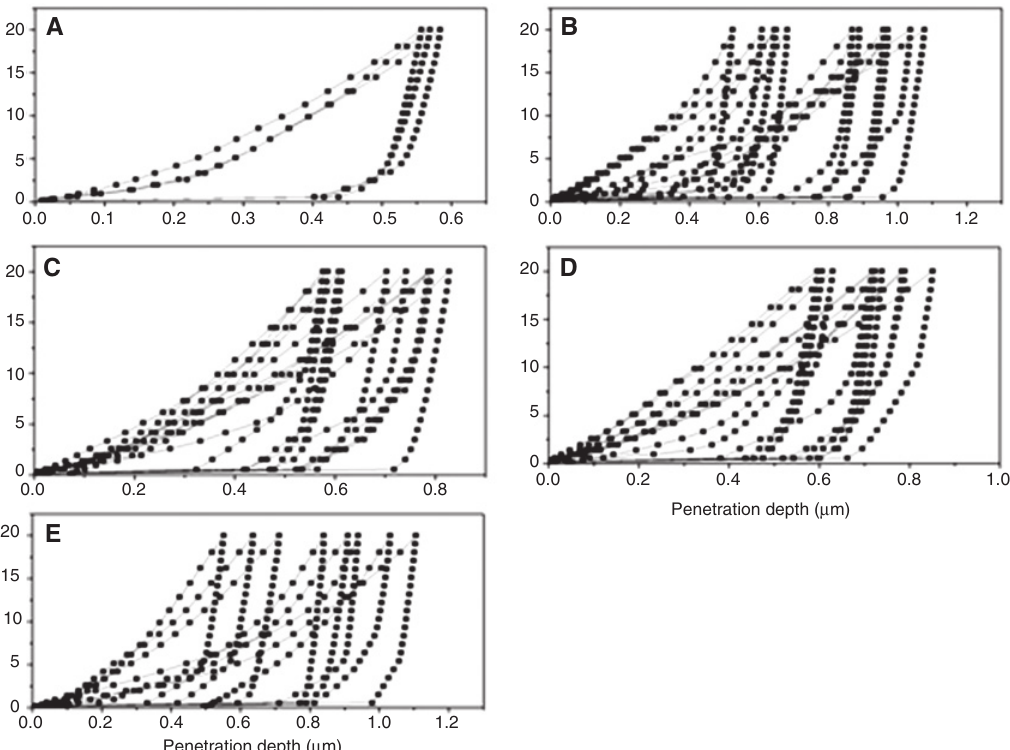
O nanocomposites for all five specimens taken from the half of the cylindrical cross 2 3